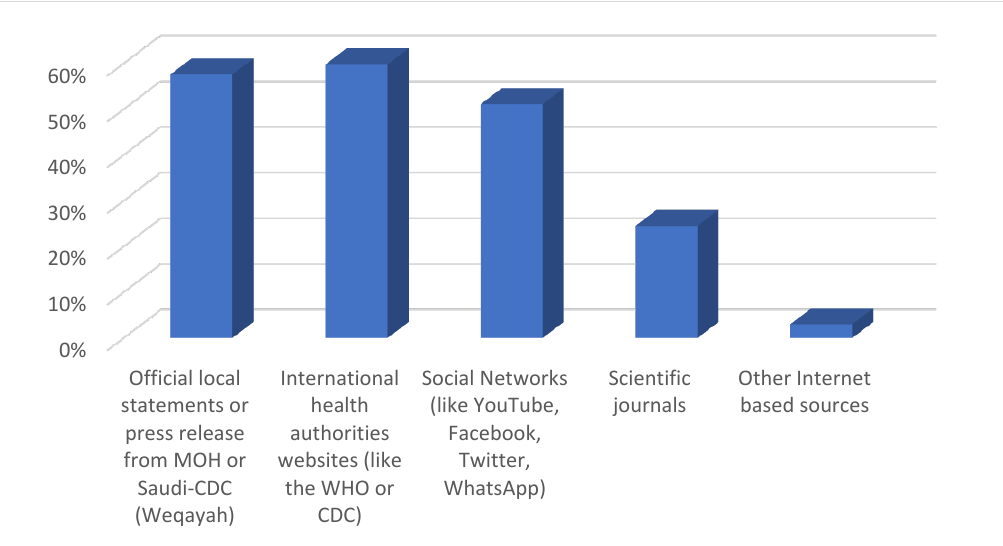
Figure A2. Public sources of information about monkeypox disease. (KSA, 27 May to 5 June 2022.)